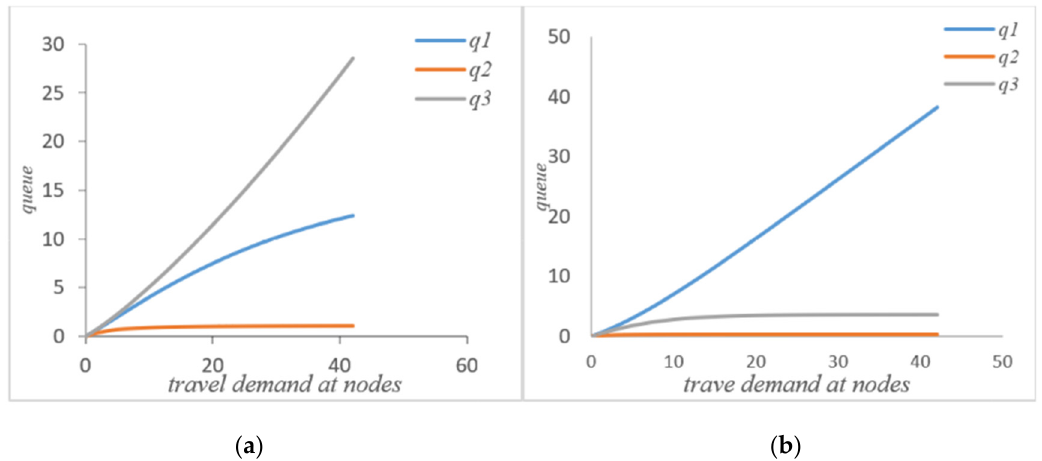
Figure 4. ( a ) Queue length without self-balancing; ( b ) queue length with self-balancing. It can be seen that after self-balancing, the queue length of node 1 has increased but the queue lengths of nodes 2 and 3 have been significantly reduced. Corresponding to the waiting time at the node in Figure 3, it can be seen that the self-balancing process is not a process of reducing the queue length at each node but rather a process of optimizing the allocation of system resources based on the coordination and balance process. Combined with Figure 8, since the system is a closed-loop system, the number of customers remains unchanged, and the self-balancing process of autonomous driving is essentially a process of optimizing the use of resources, so the average queue length of the system will not change. Figure 5a,b compare the change of traffic volume at the nodes before and after the self-balancing of autonomous vehicles in the system under the same travel conditions. The horizontal axis represents the travel demand, and the vertical axis represents the actual passing capacity at the node.